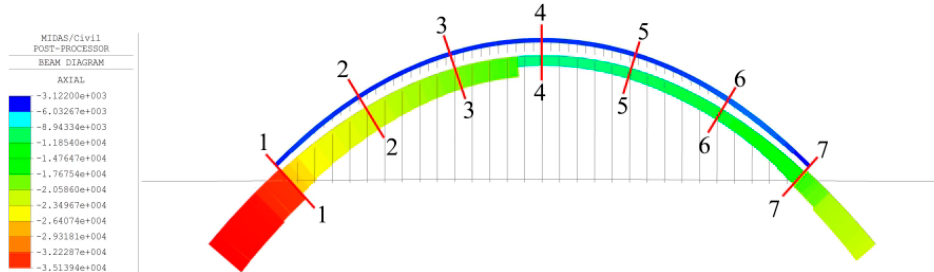
Figure 10. Axial force of arch ribs (unit: kN).